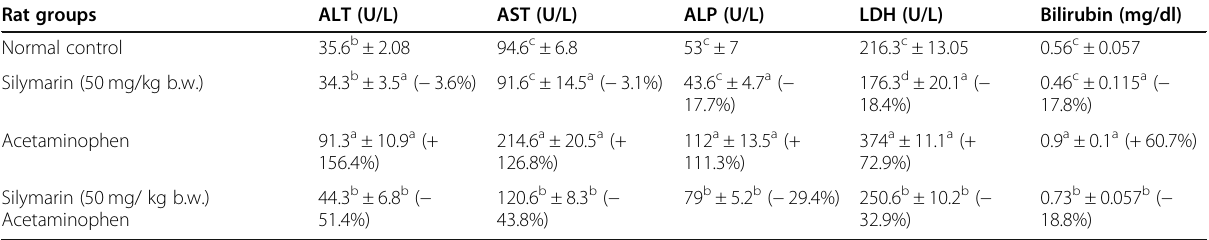
Table 3 Effect of silymarin at dose of 50 mg/kg b.w., on liver enzymes and bilirubin in normal and acetaminophen (AAP) dosed rats Rat groups Normal control